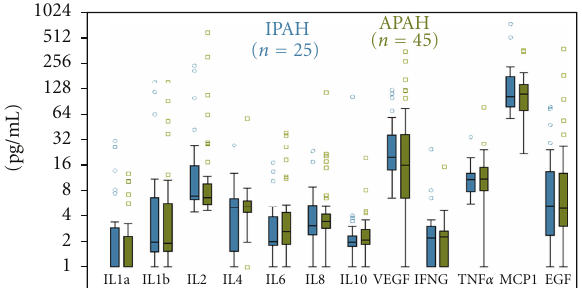
Figure 1: Biomarker characteristics: the distribution of the 12 cytokine and growth factor measurements based on disease clas- sification. The y -axis is displayed on the log (base 2) scale. Filled areas indicate the interquartile range (distance between 25th and 75th percentiles), the middle line corresponds to the median, and the whiskers contain data within 1.5 interquartile ranges. None of the di ff erences was statistically